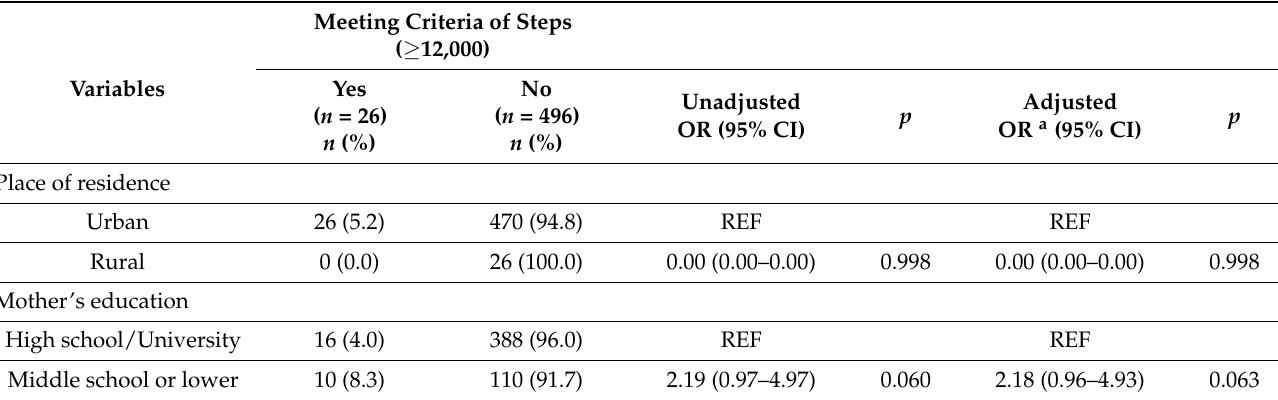
Table 6. Linking the parameters of meeting the steps/day criterion ( ≥ 12,000) to socioeconomic